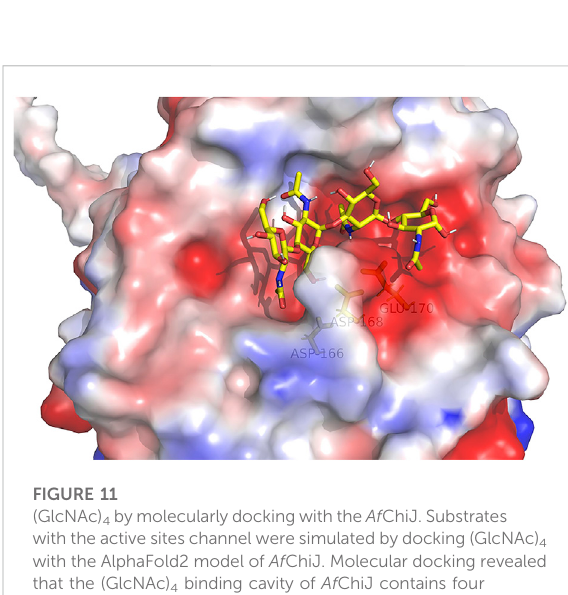
FIGURE 11 (GlcNAc) 4 by molecularly docking withthe Af ChiJ.Substrates with the active sites channel were simulated by docking (GlcNAc) 4 with the AlphaFold2 model of Af ChiJ. Molecular docking revealed that the (GlcNAc) 4 binding cavity of Af ChiJ contains four glycosyl binding sites, and that the predicted catalytic residue